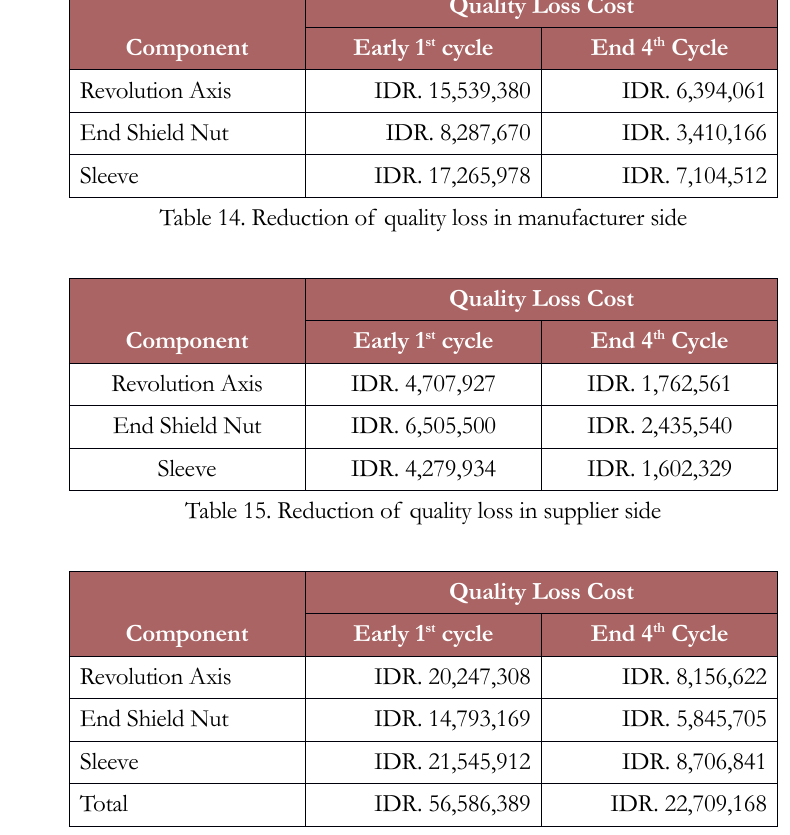
Table 16. Total reduction of quality